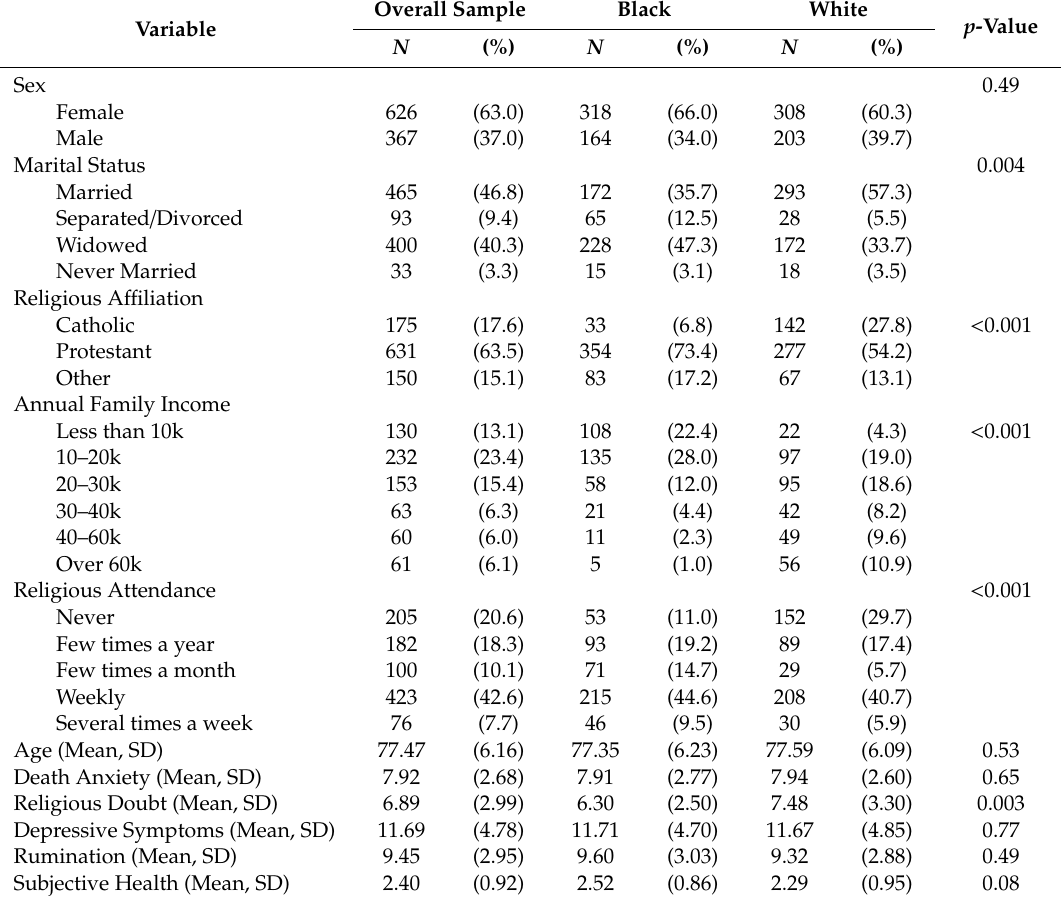
Table 1. Distribution of Sociodemographics, Death Anxiety, Depressive Symptoms, Religious Doubt, Rumination, and Subjective Health between Black and White Older Adults. Overall Sample Black